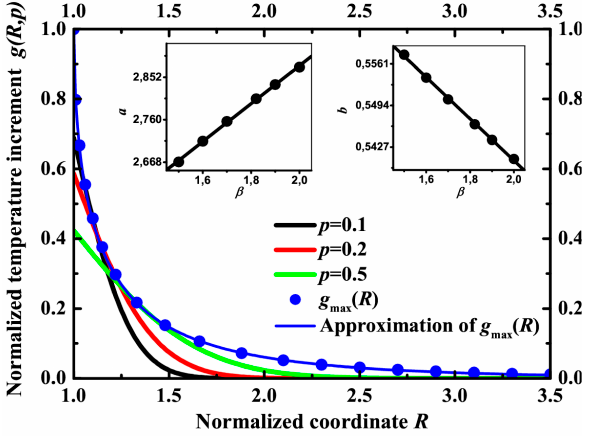
Figure 8. The distribution of normalized temperature g vs. normalized coordinate R at different moments of time: p = 0.1 (black line), p = 0.2 (red line), p = 0.5 (green line). Blue dots demonstrate the spatial distribution of the maximum temperature. The blue line is its approximation by g max ( R ) = exp( − a ( R − 1) b ). Inset: parameters a and b vs. coefficient β and their linear approximation by a = 2.06 + 0.41β and b = 0.61 − 0.034β .